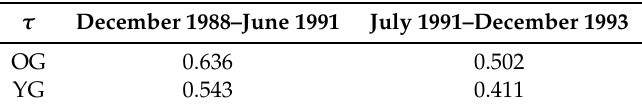
Table 4. Kendall’s τ across two close observations windows.